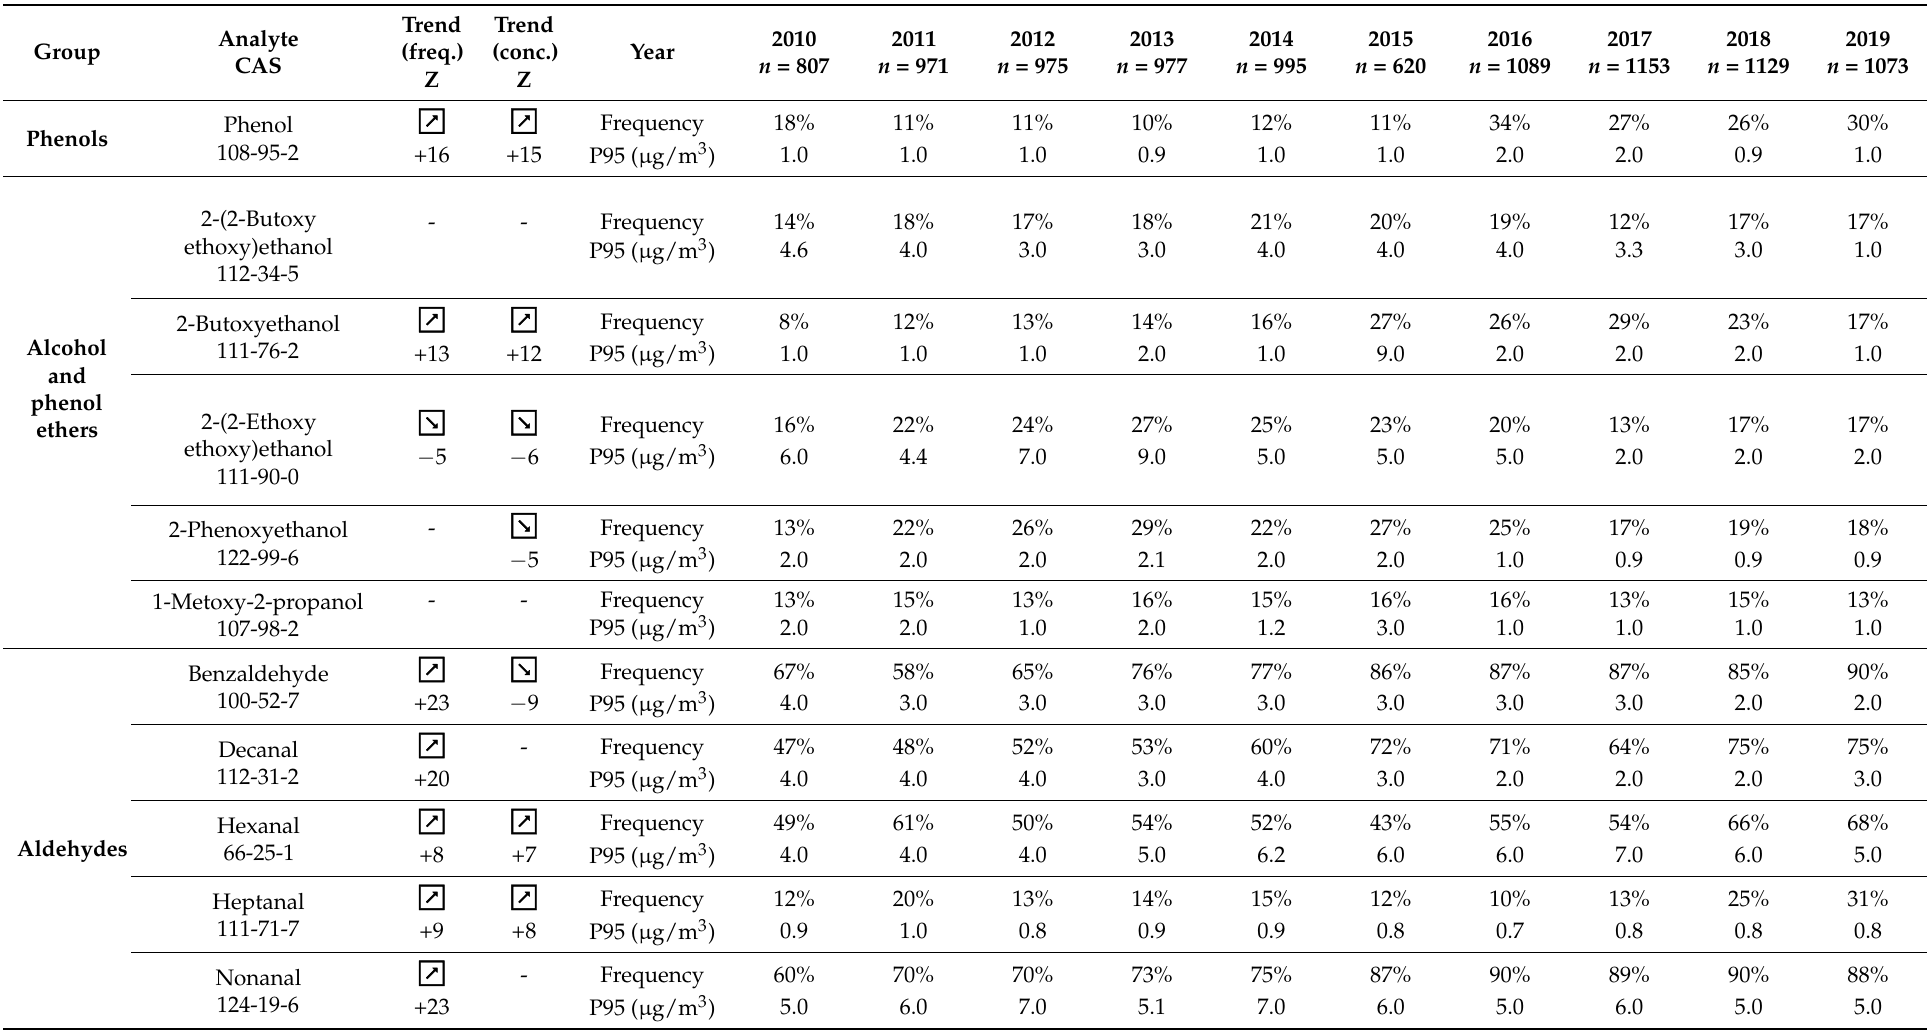
Table 4. Annual statistics of VOCs (a) and formaldehyde (b) during the ten-year study period 2010–2019. Frequency trend was tested using Somer’s D test, where input data were binomial (measurement result either >LOQ or <LOQ). Concentration trend was tested using Somer’s D test, where input data comprised all measured concentration values. Here, measurement results that were <LOQ were replaced by a concentration value LOQ/2. Trends indicated by downward or upward arrow symbol were statistically significant ( p < 0.0001) and had ǀ Z ǀ ≥ 4. Z values shown below arrow symbols indicate direction and steepness of trend. (a) Annual frequency and P95 values of the 42 most common VOCs during the ten-year study period 2010–2019. For TVOC presented on the bottom line, median, and P90 values are also shown.